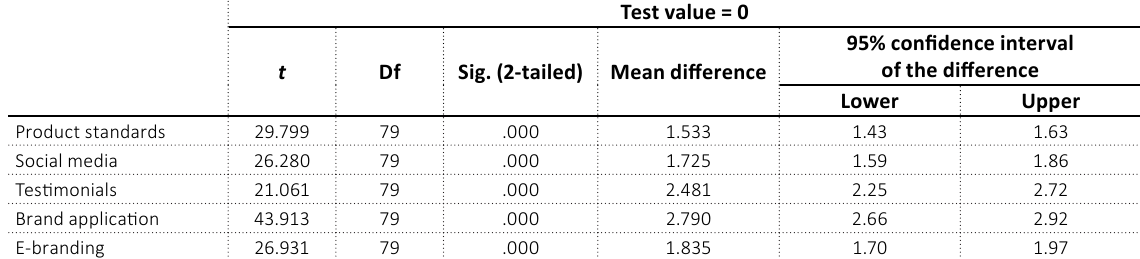
Table 9. One sample